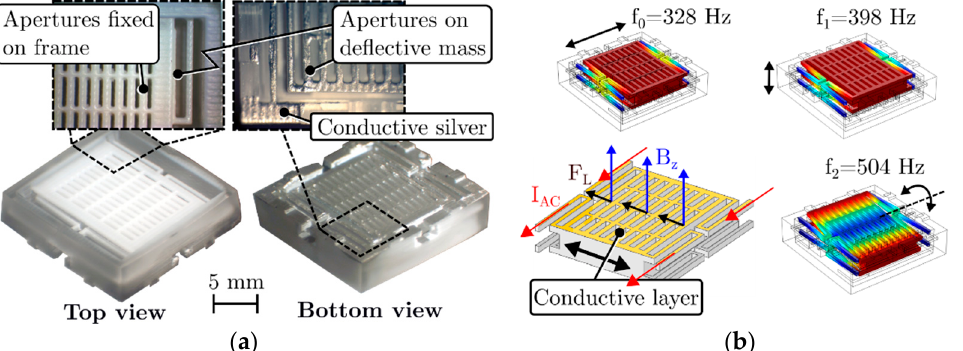
Figure 1. ( a ) 3D-printed magnetometer designed with 32 apertures with a particular size of 400 × 2000 µ m and coated with conductive silver. ( b ) Schematic representation of the Lorentz force principle and FEM simulation results of the first three eigenmodes.